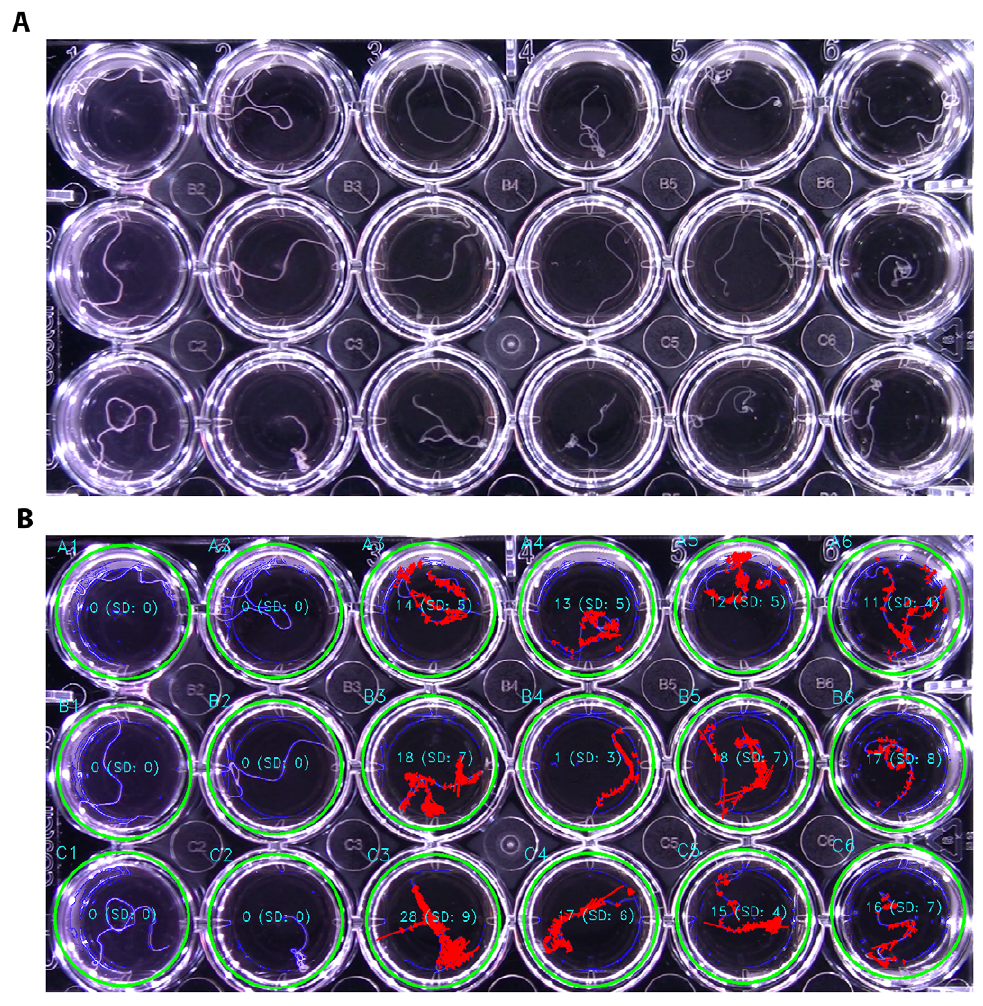
Figure 2. Microtiter plate images and application real-time preview. (A) Video frames of 24-well plates of Brugia malayi were recorded using the apparatus. (B) Screen capture of the software’s real-time preview user interface. Green circles indicate that the wells have been detected and that the program is ready to begin recording data. The blue outline in each well is the worm (or other well artifacts) and the red color indicates the worm’s movements. Mean movement units are measured in real-time and are shown for each well using the Lucas-Kanade Optical Flow algorithm. Canonical well labels determined by the well finding algorithm are drawn in teal in the preview image by the application. (There is no movement in the 2 left columns because the worms are dead due to high drug